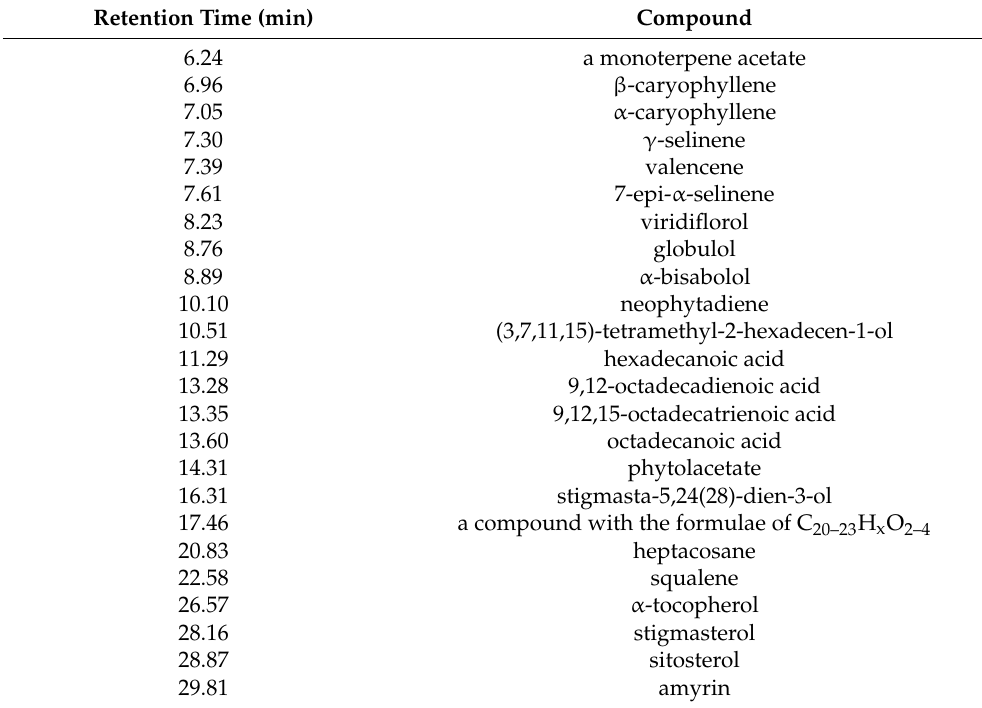
Figure 2. Total ion chromatogram of the DCM extract of P. zeylanicus . Table 2. Tentatively identified compounds in the DCM extract of P. zeylanicus